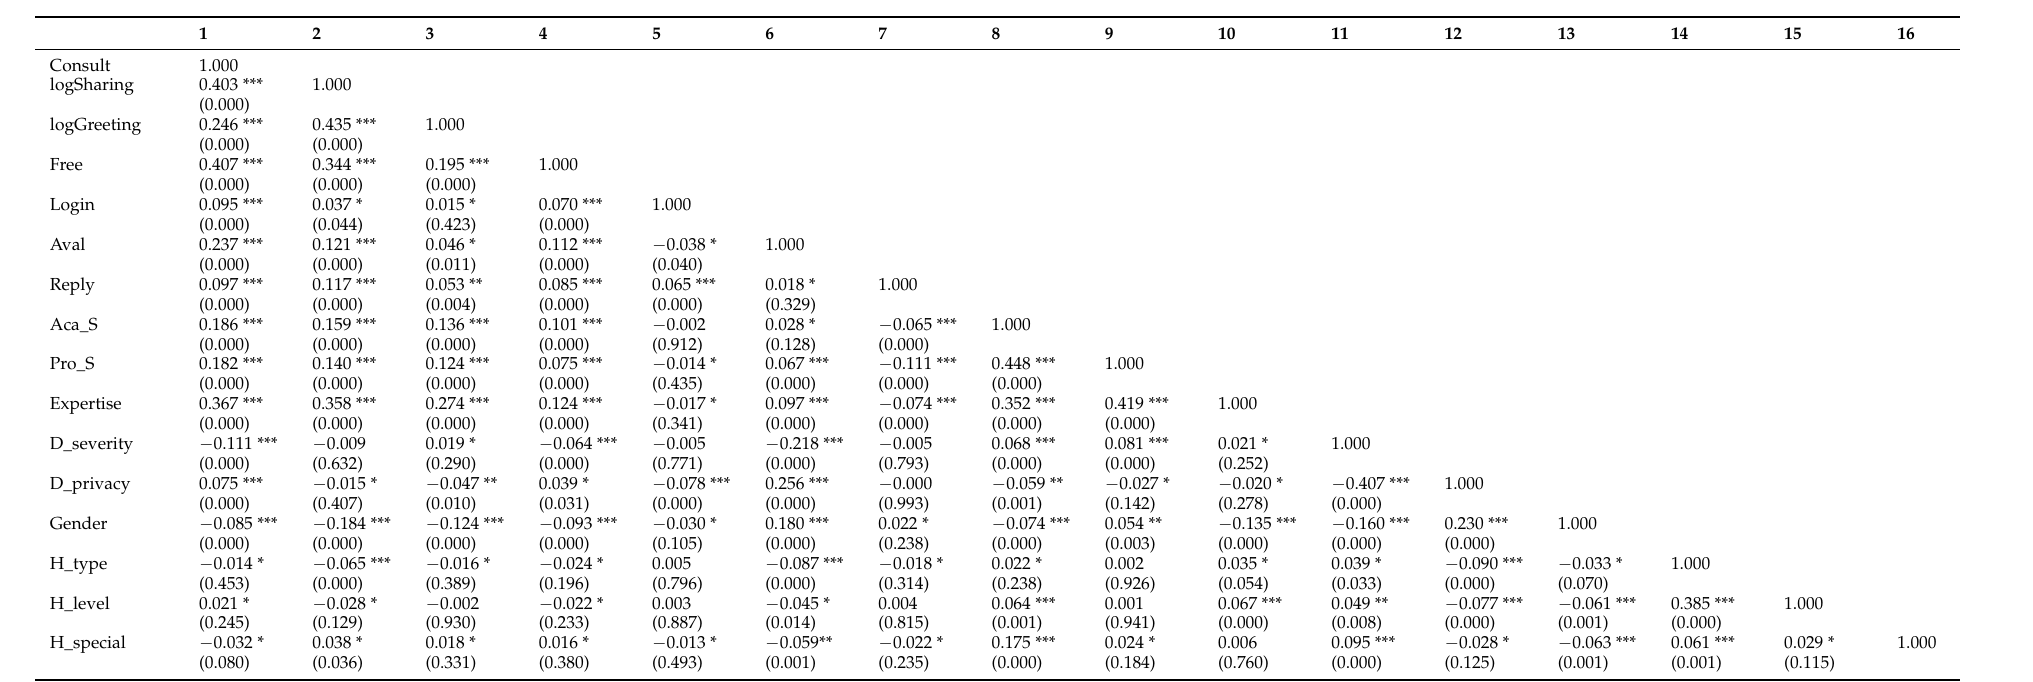
Table 2. Correlation coefficient